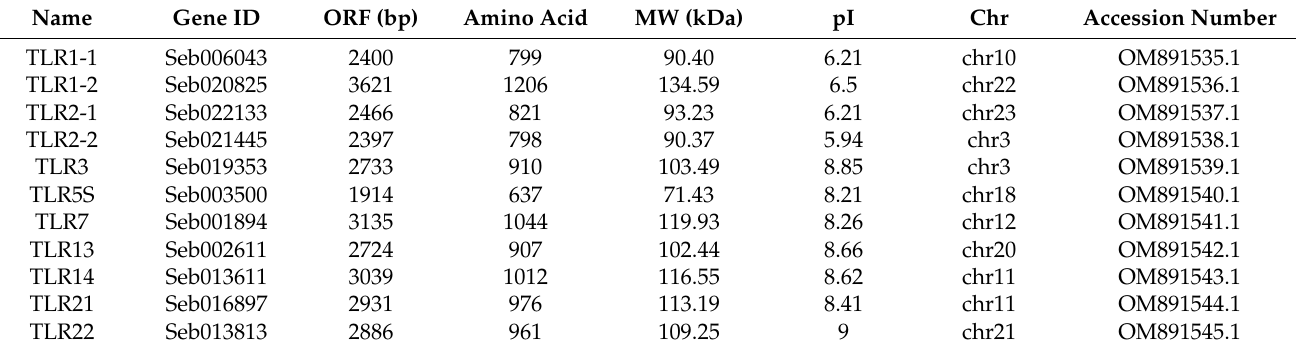
Table 1. Summary of TLR genes identified in marbled rockfish